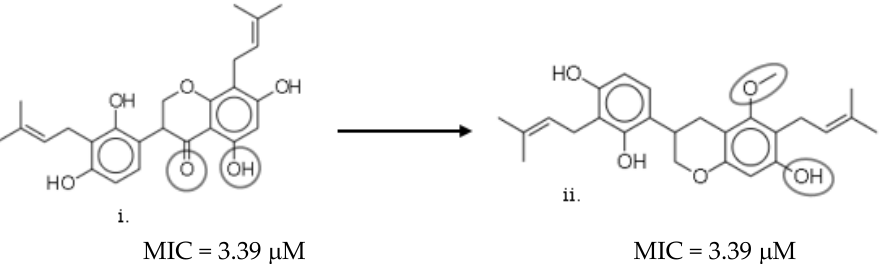
Figure 16. Scatter plot of the structure–activity relationship landscape of AMNPs. Markers were colored by delta activity and sized by SALI (structure–activity landscape index). Red markers (X) represent smooth regions of the SAR landscape. Pink, purple, and blue (Y) markers represent compounds that exhibited activity cliff.